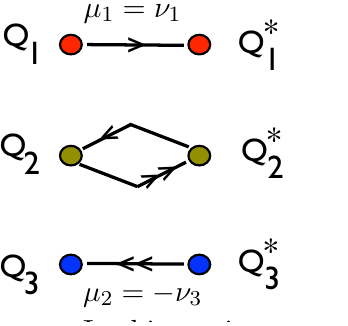
mesons for di(cid:11)erent color i (cid:22) 1 ), respectively. (cid:0)